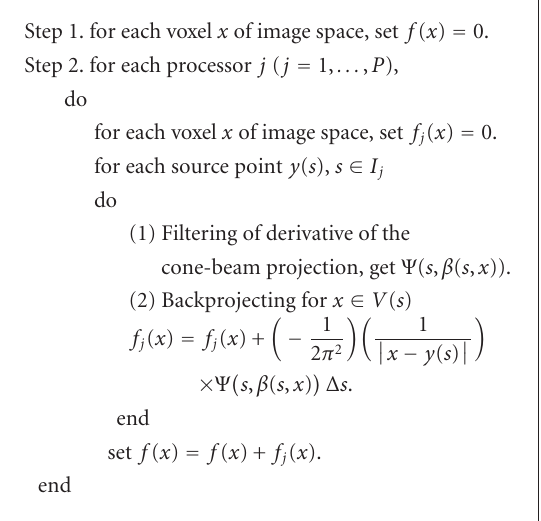
Algorithm 2: Parallel implementation of Katsevich’s FBP inversion formula.